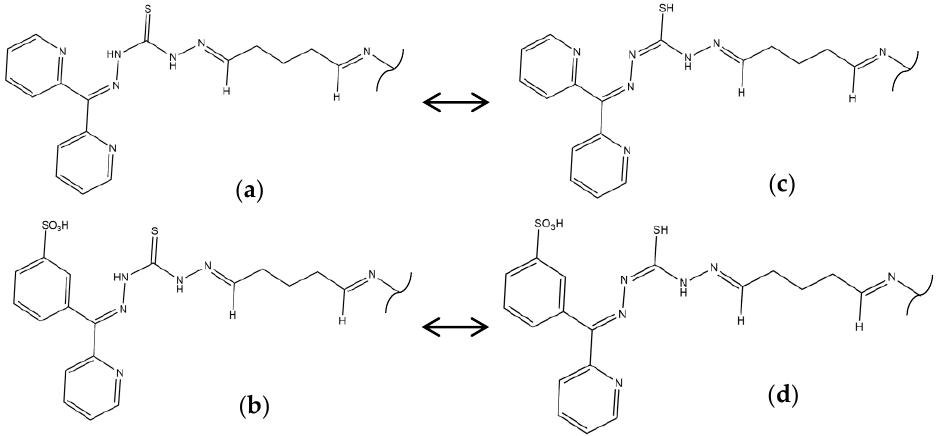
Figure 4. Tautomeric equilibrium of C=S bond ( a , c ) DPTH tautomers; ( b , d ) PSTH tautomers.